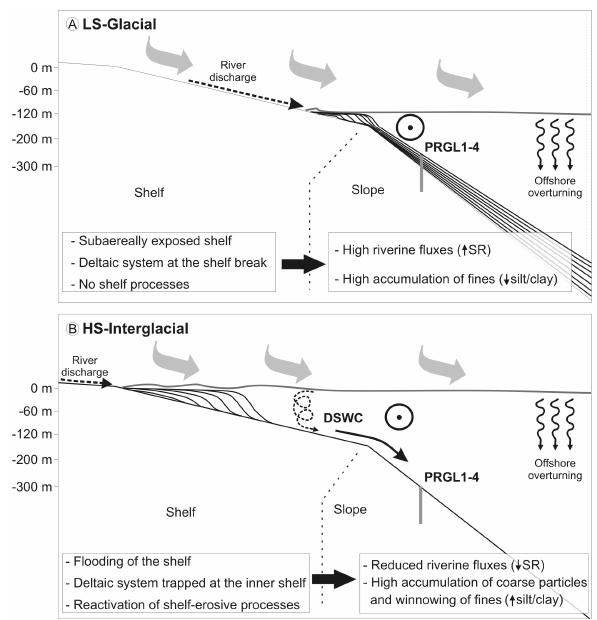
Fig. 4. Conceptual depositional model of the Gulf of Lion conti- nental margin at orbital scale. (A) During the lowstand (LS) depo- sitional mode (glacial periods) the continental shelf is subaerially exposed and the basinwards migration of deltaic system results in high amounts of fine particles supplied directly to the upper slope. (B) Flooding of the shelf during the high-stand (HS) depositional mode (interglacial periods) traps deltaic systems in the inner shelf, thus, disconnecting the upper slope from direct fluvial discharges. Moreover, the creation of a relatively thin layer of water over the continental shelf reactivates shelf erosive processes, such as Dense Shelf Water Cascading (DSWC), that are able to transport coarse particles down the slope. Both processes contribute to generate thin condensed layers (CLs) in the upper slope. Grey arrows represent the northern winds involved in cooling the superficial shelf water for dense shelf water formation and offshore overturning. Dot in a circle shows the dominant direction of the slope-parallel Northern Current. The discontinuous spiral arrow over the shelf represents shelf-erosive processes, as